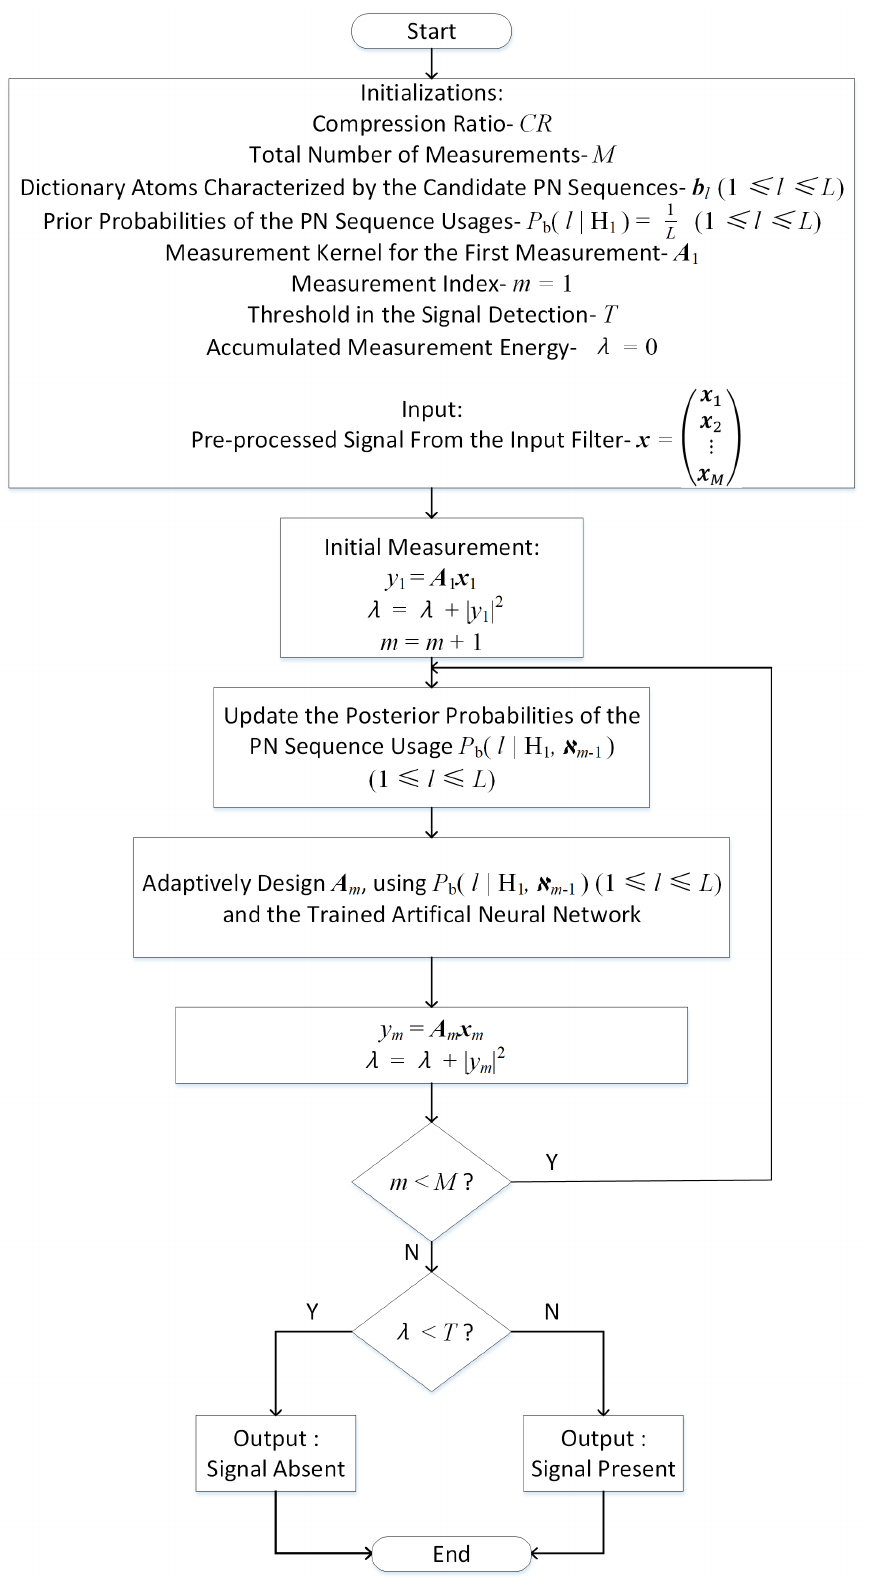
Figure 3. The Proposed Adaptive Measurement and Detection Procedure of the DSSS